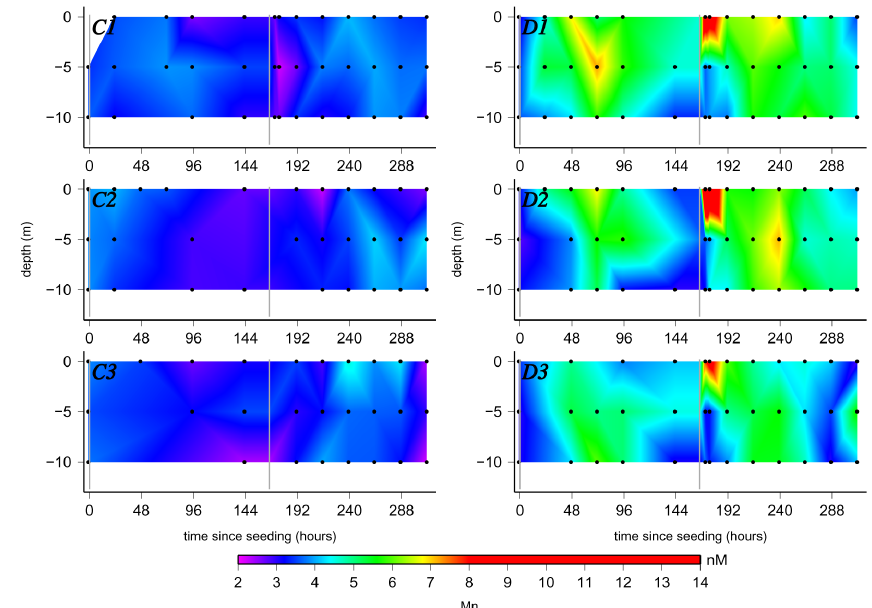
Fig. 1. Evolution of dissolved manganese (Mn) in the 6 mesocosms (left hand side – control mesocosms: C1, C2 and C3; right hand side – dust seeded mesocosms: D1, D2 and D3). The graphs are plotted as the time since the first seeding (h) versus the depth (m) in the mesocosms. Black dots show the points were samples were taken. The two grey vertical bars highlight the time points when the seeding took place (t0 and